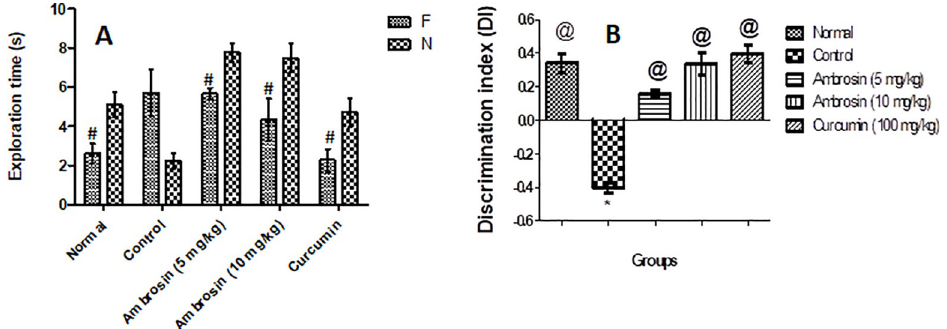
Fig 3. Effect of different treatments on LPS-induced memory deterioration in mice utilizing the object recognition test. a) Exploration time of familiar (F) vs. the novel object (N). b) Discrimination index (DI) Results are expressed as mean ± SEM (n = 8). Statistical analyses were carried out a) by using Student’s t-test, while in b) by one-way ANOVA followed by Tukey’s multiple comparison test. # Significant difference versus correspondent N group at p < 0.05. � Significant difference from normal group at p < 0.05. @ Significant difference from control (LPS) group at p < 0.05.